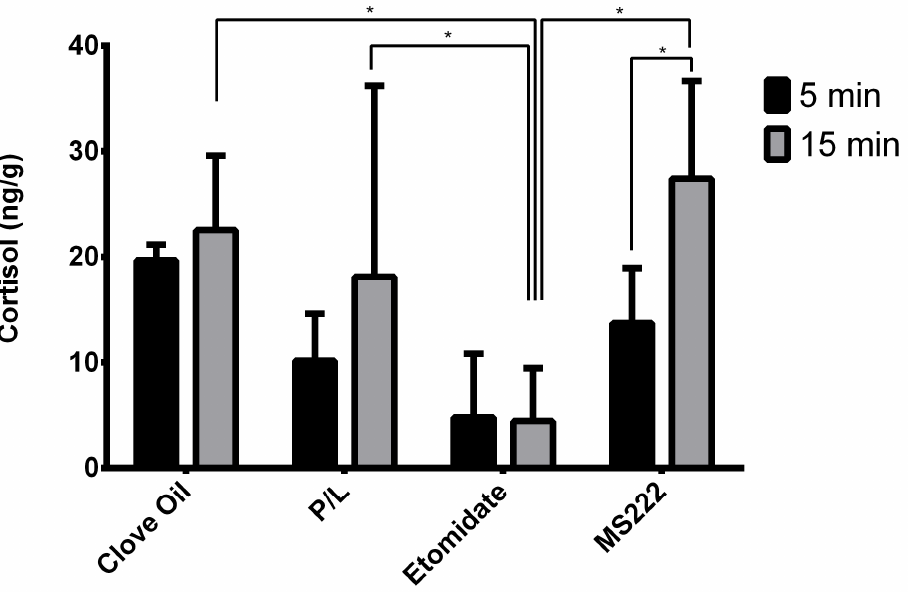
Figure 5. Observed medians of trunk cortisol levels 5 min or 15 min after zebrafish had lost their equilibrium and their interquartile ranges. Clove Oil group: animals subjected to 45 mg/L of clove oil (n = 12); P/L group: animals subjected to 5 mg/L of propofol combined with 150 mg/L of lidocaine (n = 11); Etomidate group: animals subjected to 2 mg/L of etomidate (n = 10); MS222 group: animals subjected to 150 mg/L of MS222 (n = 12). * p ≤ 0.003 significant differences between least-square means of groups and phases using the GLM procedure.